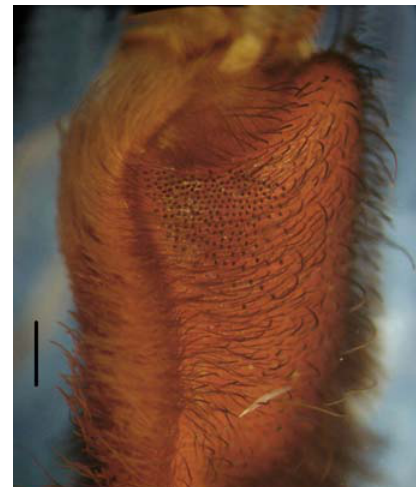
Image 7. Cuspules on maxillae. Scale 1.0mm